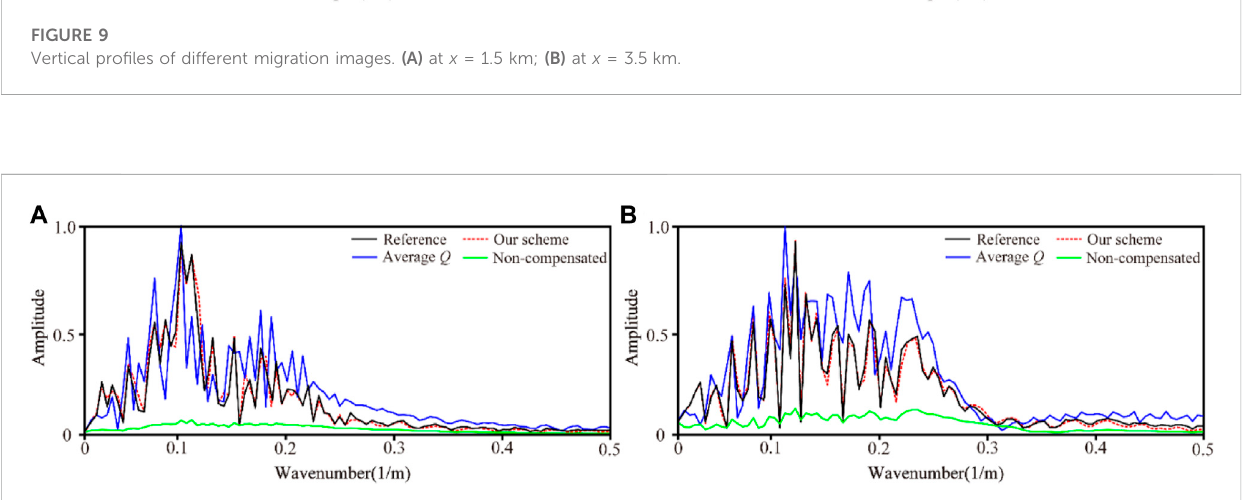
FIGURE 10 Amplitude spectra corresponding to the migrated seismic traces (A) at x = 1.5 km; (B) at x = 3.5 km.